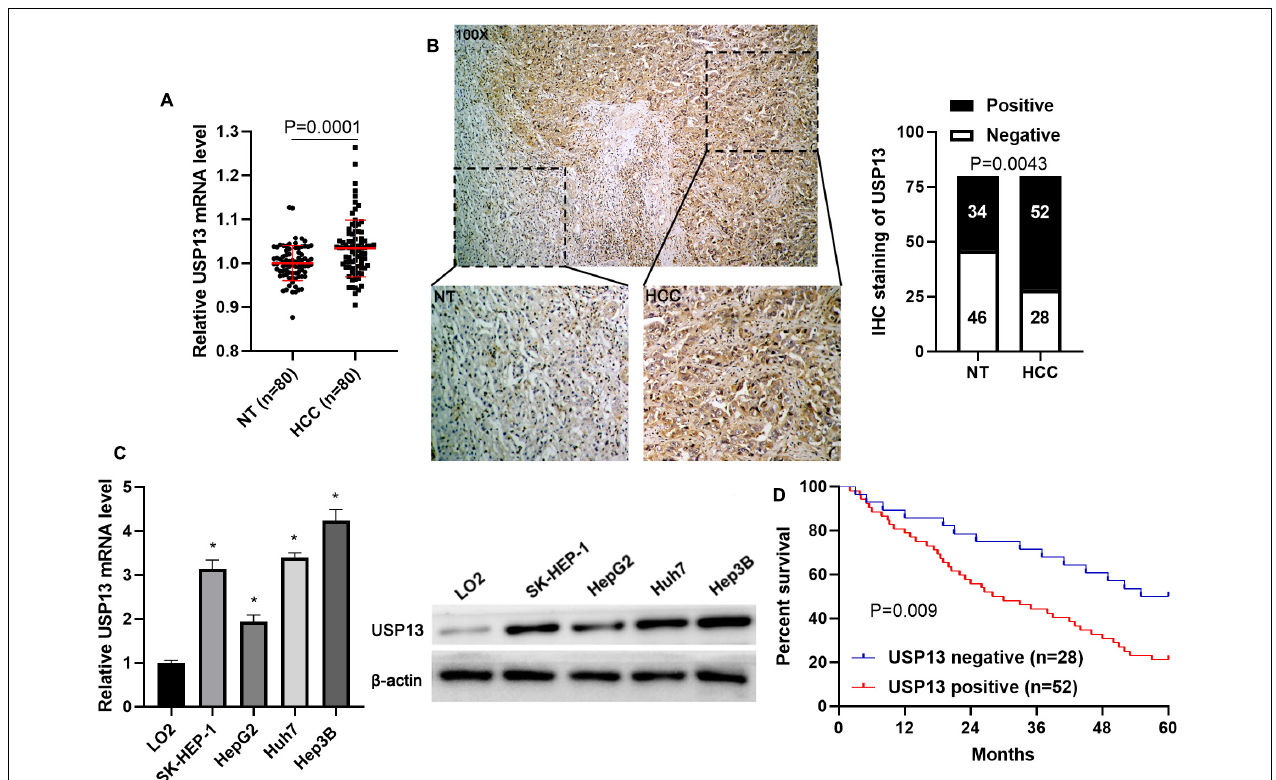
FIGURE 1 | USP13 expression is upregulated in HCC. (A) qRT-PCR was performed to detect USP13 mRNA levels in 80 pairs of HCC and adjacent non-tumor (NT) tissues. (B) IHC staining of USP13 in a representative sample containing HCC and adjacent NT tissues. The staining intensity of USP13 in HCC was significantly higher than that in NT tissues. (C) The expression of USP13 protein in HCC cell lines (SK-HEP-1, HepG2, Huh7, and Hep3B) and a normal hepatic cell line (LO2). (D) HCC patients with positive expression of USP13 showed an apparent shorter overall survival than cases with negative expression of USP13. * P <